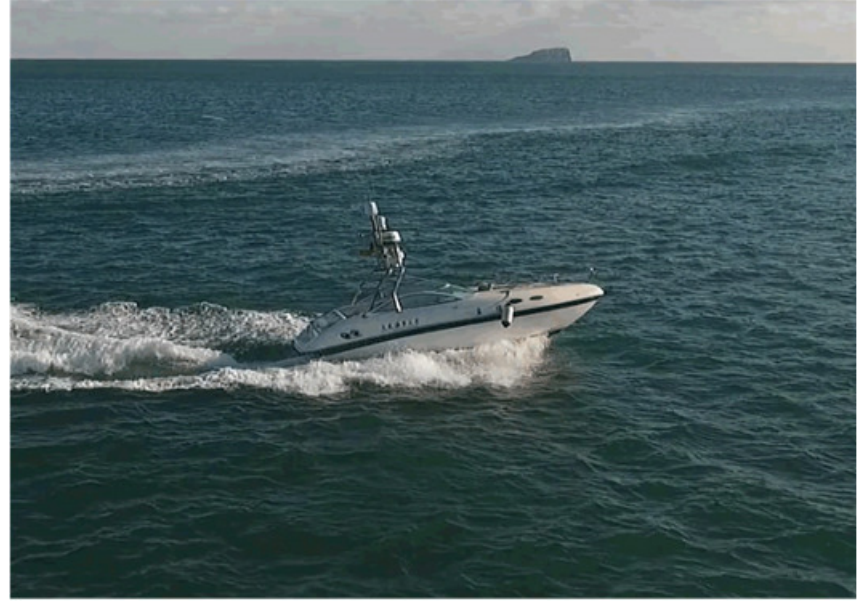
Figure 13. “Lan Xin”